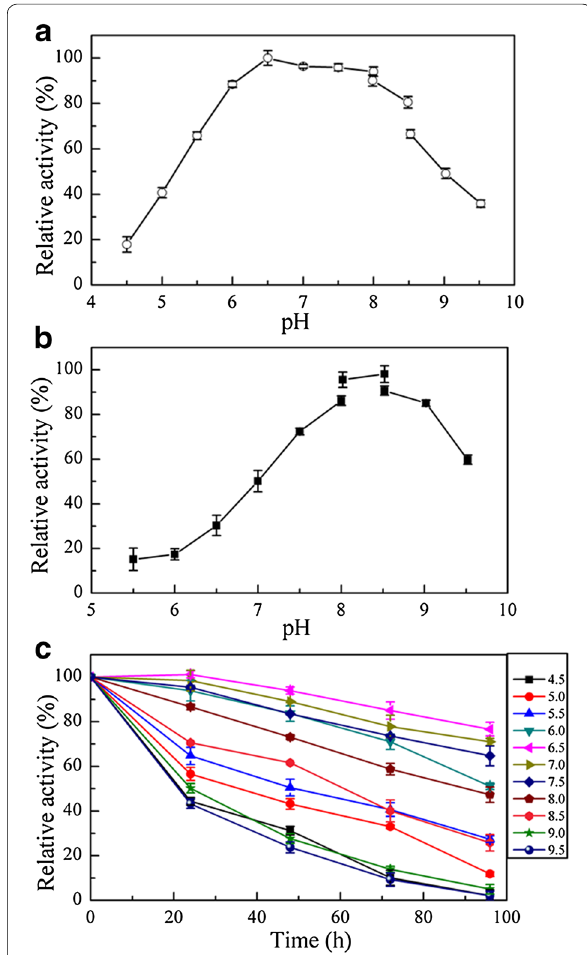
Fig. 5 Effects of pH on the activity and stability of the recombinant AcCR. Reaction conditions: a 0.25 mM NADH, 2 mL 50 mM buffer (pH 4.5–9.5), and 5 mM 4 ′ ‑chloroacetophenone were incubated at 35 °C for 5 min before adding 20 μL purified recombinant AcCR (about 0.008 mg of the purified enzyme), and then the changes of absorbance for 3 min at 35 °C were recorded; b 0.5 mM NAD + , 2 mL 50 mM buffer (pH 5.5–9.5), and 150 mM isopropanol were incubated at 45 °C for 5 min before adding 20 μL purified recombinant AcCR (about 0.008 mg of the purified enzyme), and then the changes of absorbance for 3 min at 45 °C were recorded; c 0.25 mM NADH, 2 mL 50 mM buffer (pH 4.5–9.5), and 5 mM 4 ′ ‑chloroacetophenone were incubated for 5 min at 35 °C, then 20 μL purified recombinant AcCR was added (about 0.008 mg of the purified enzyme), and the changes of absorbance for 3 min were recorded